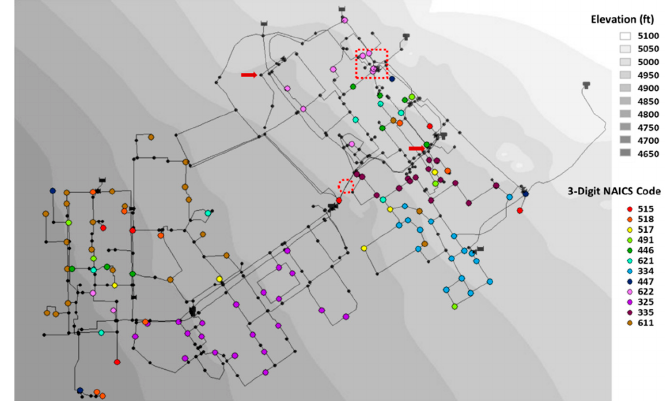
Figure 3. The layout of the U-City water distribution system (WDS). Dotted rectangle and circle highlight important locations of pipes noted later in the results that have significant loss of hydraulic resilience and economic consequence resilience. The node pointed to by the arrow is where minimum pressure is violated without any pipe Table 1. Candidate NAICS code for U-City and water cost information, number of the EPANET model nodes serving the NAICS code, and total demand for the nodes serving the NAICS code following Lee et al. [22] .